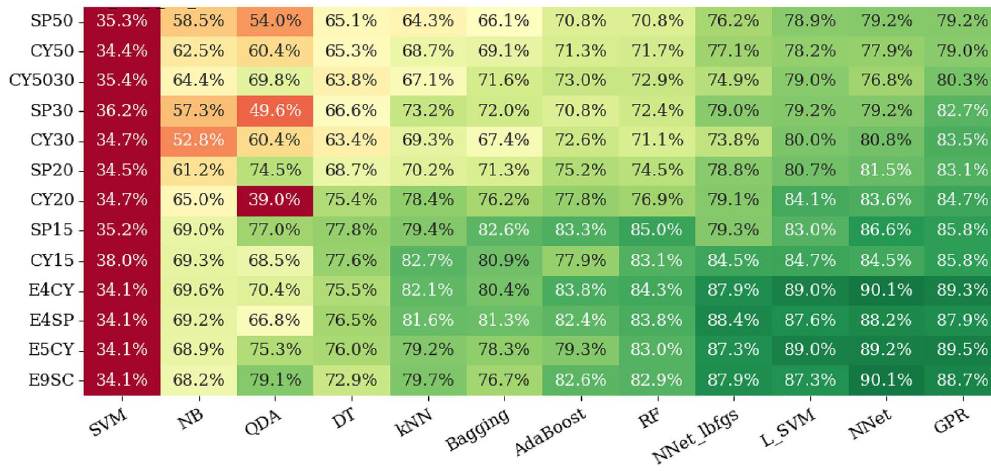
Figure 8. The F-1 score grid for different combinations of ML classifiers (x-axis) and ROIs (y-axis) with different sizes and shapes with LASSO FS